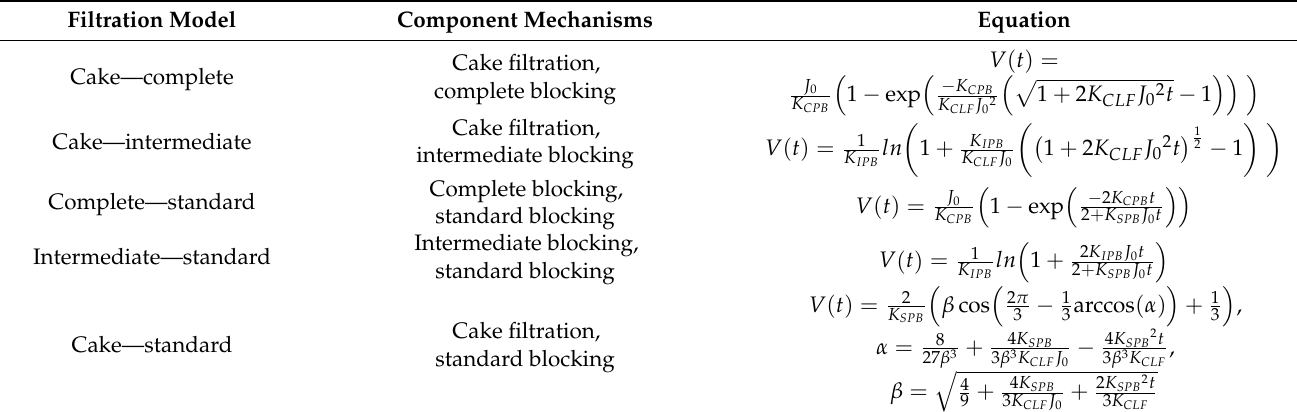
Table 2. Bolton’s combined models in terms of V = f ( t ) for constant pressure